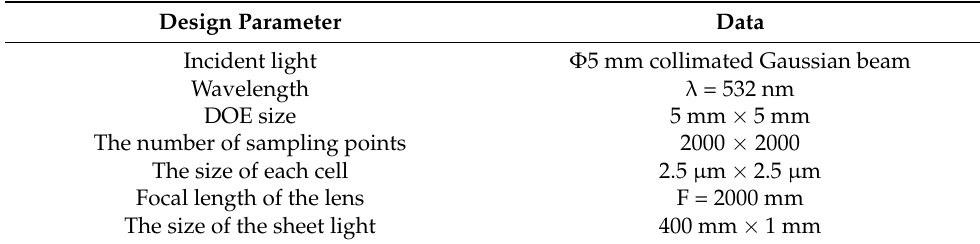
Table 1. The design parameters of the sheet optical system.